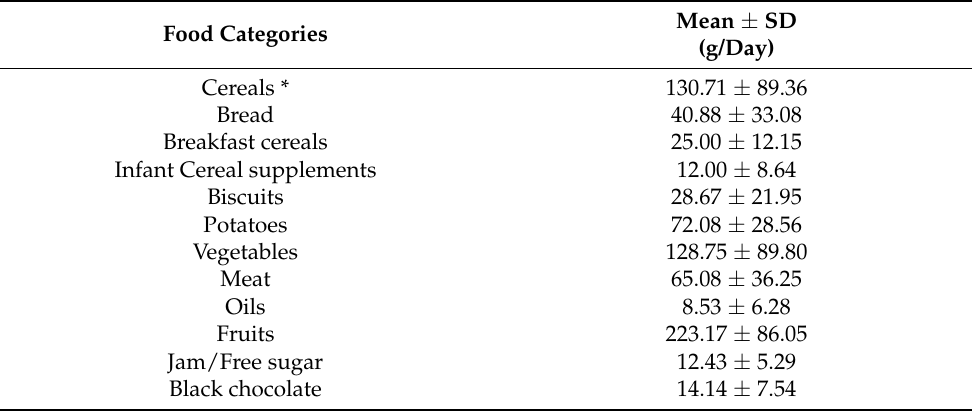
Table 4. Means of solid food intake per day, according to the food categories (n = 30).